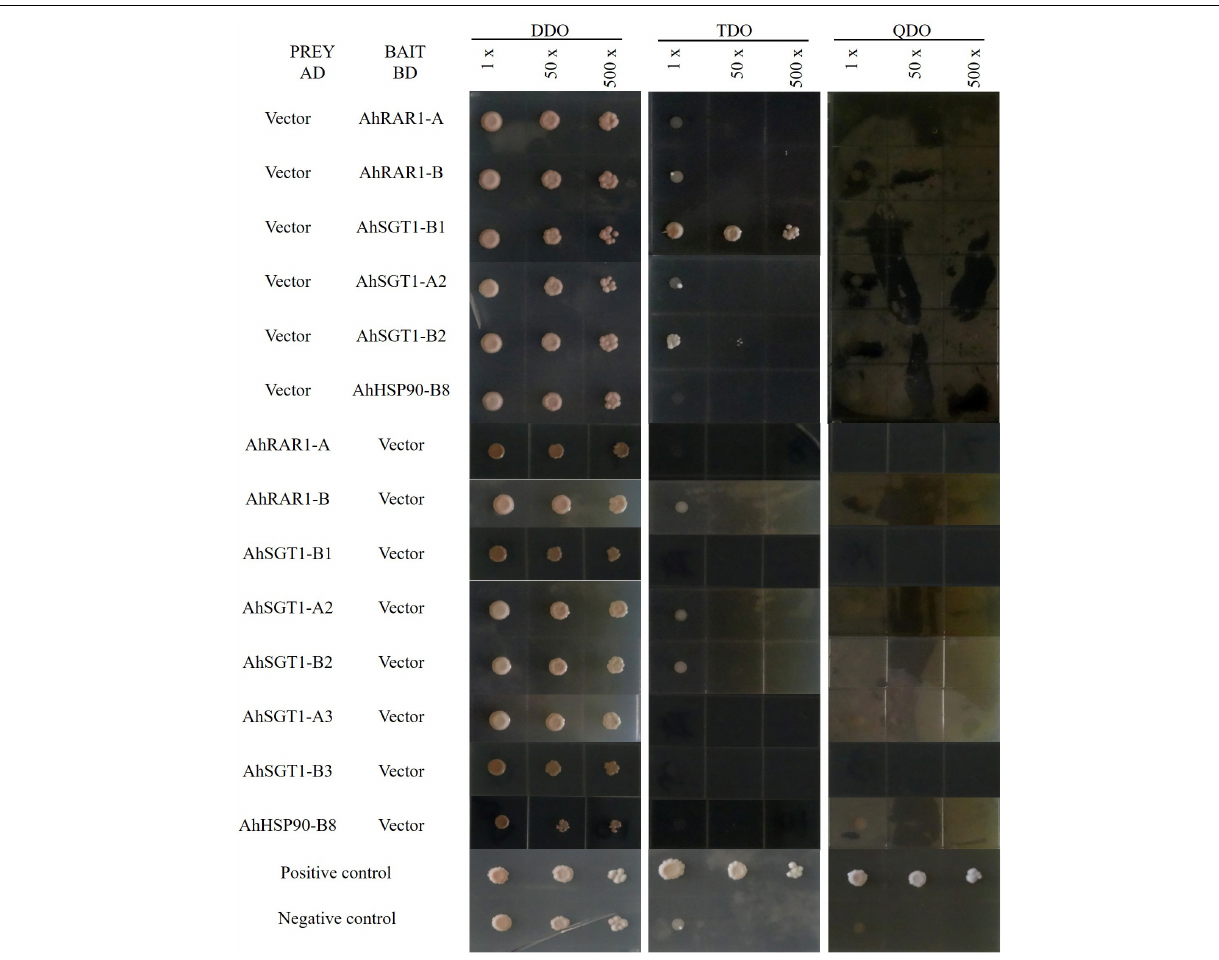
AdHSP90-3 , AiHSP90-3 , AhHSP90-A3 , and AhHSP90-B3 is